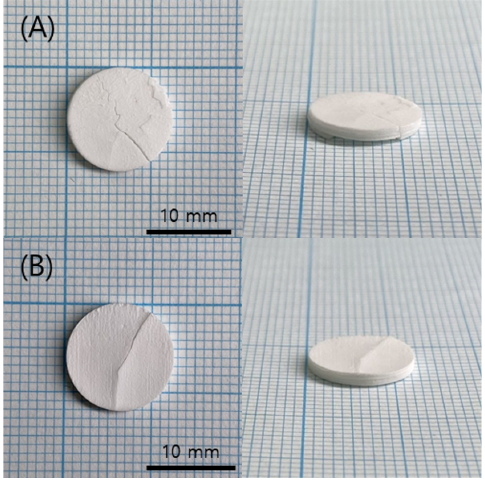
Figure 10. Sintered specimens according to various chamber temps: ( A ) 40 °C; ( B ) 60 °C.